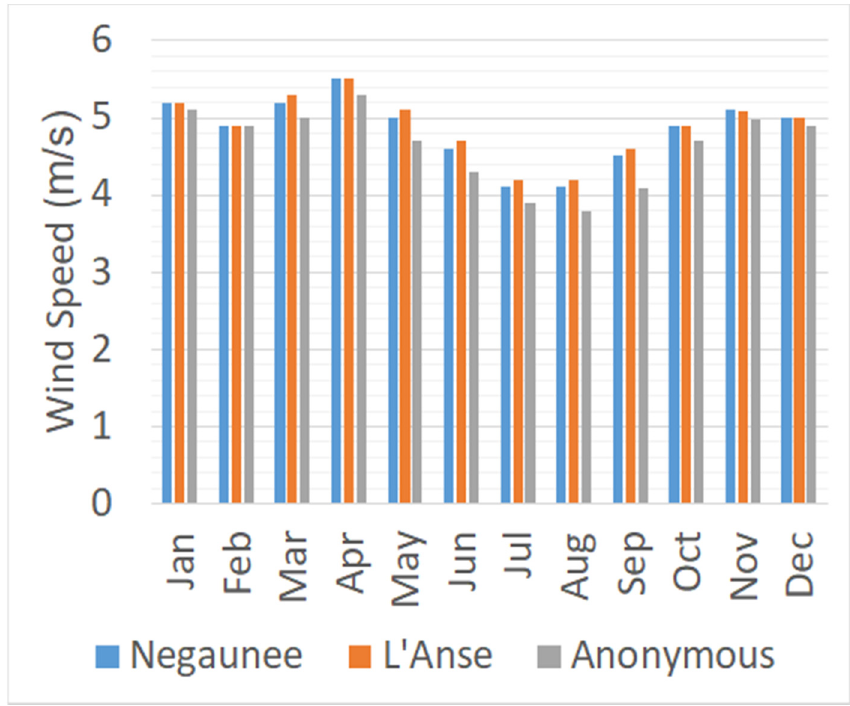
Figure 7. The average monthly wind speeds at each simulated location at 100 m above